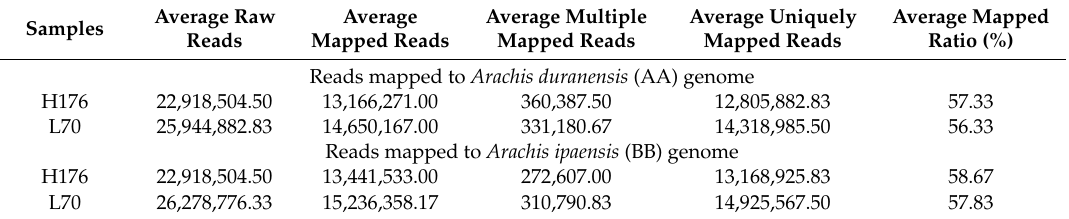
Figure 1. Morphology and fatty acid profiles during the high- and normal-oleic peanut seed development. ( A , B ) Phenotypes of L70 and H176 plants. ( C ) Seed samples harvested from six different development stages (20–70 days after flowering (DAF)) in L70 and H176. ( D – F ) These histograms display the dynamic changes of total oil, oleic acid, and linoleic acid along with seed development. Values are shown as the mean ( ± SD) of three biological replicates, and asterisks indicate a significant difference (* p < 0.05, ** p < 0.01) when compared with the normal-oleic peanut variety L70. ( G ) Four mutant sites located at FAD2-A coding region in H176 to generate a stop codon (TGA) at the 375 bp position, inducing the termination of protein synthesis. ( H ) Gene structure of FAD2-B in H176. Twelve mutant sites exist in the coding sequence. An adenine was inserted at the 442 bp position, thus generating a stop codon (TAA) at the 495 bp position. MR: mutant region. Table 1. Statistical analysis of RNA-seq raw-reads mapped to the ancestor